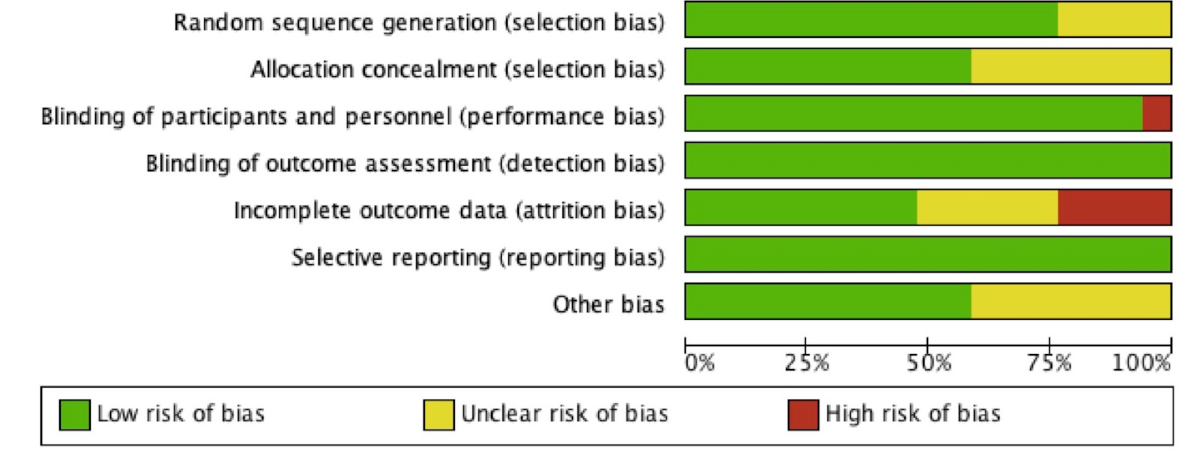
Fig 7. Risk of bias